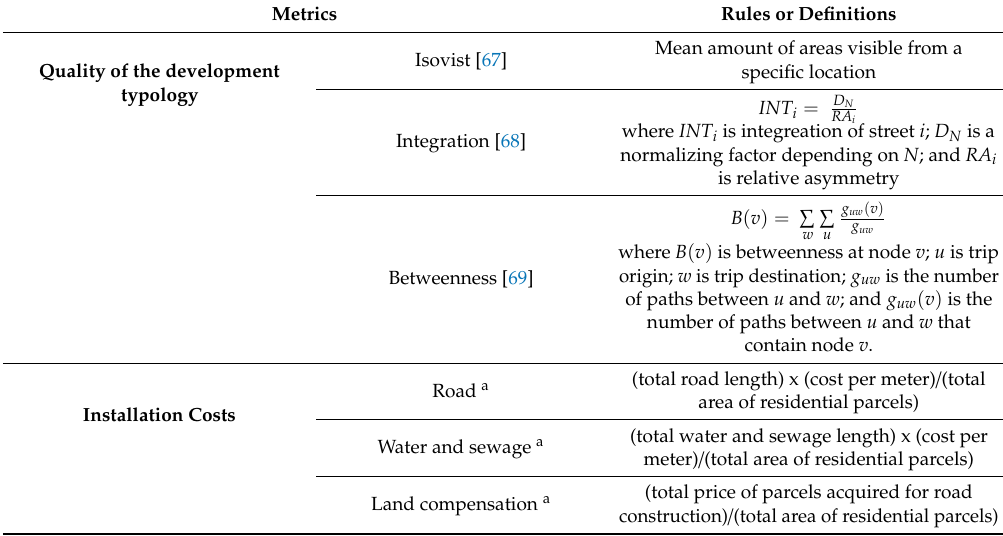
Table 2. Metrics and their rules of definitions for measurements.